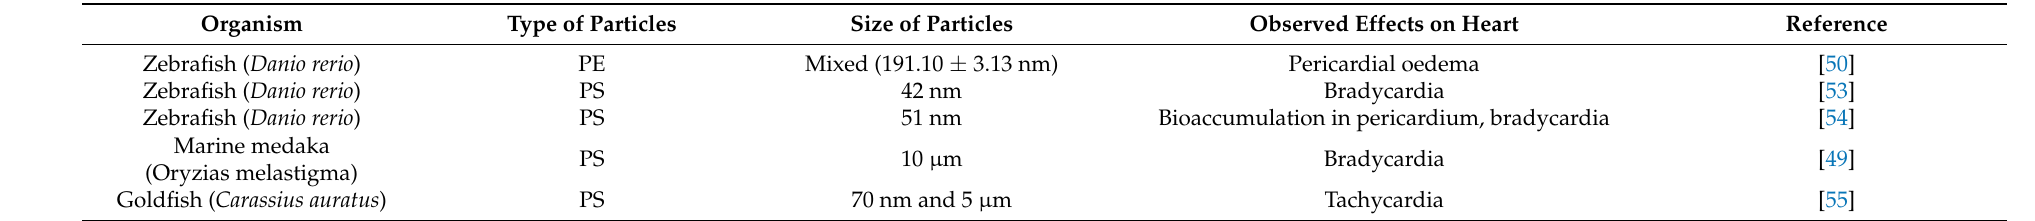
Table 2. Main characteristics of MPs/NPs and effects on cardiac tissue of aquatic fauna. PE: polyethylene; PS: